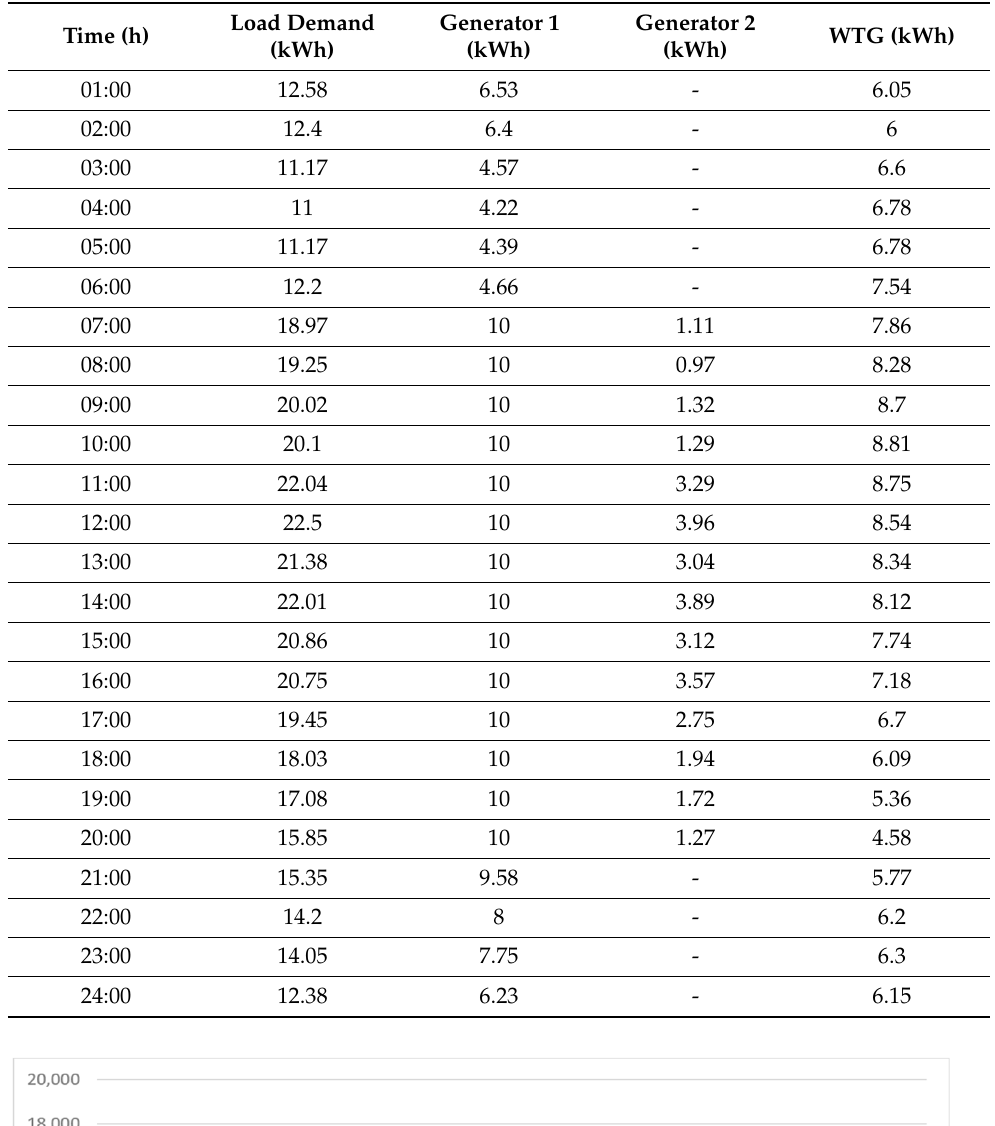
Table 5. Optimal power output for Case 2.